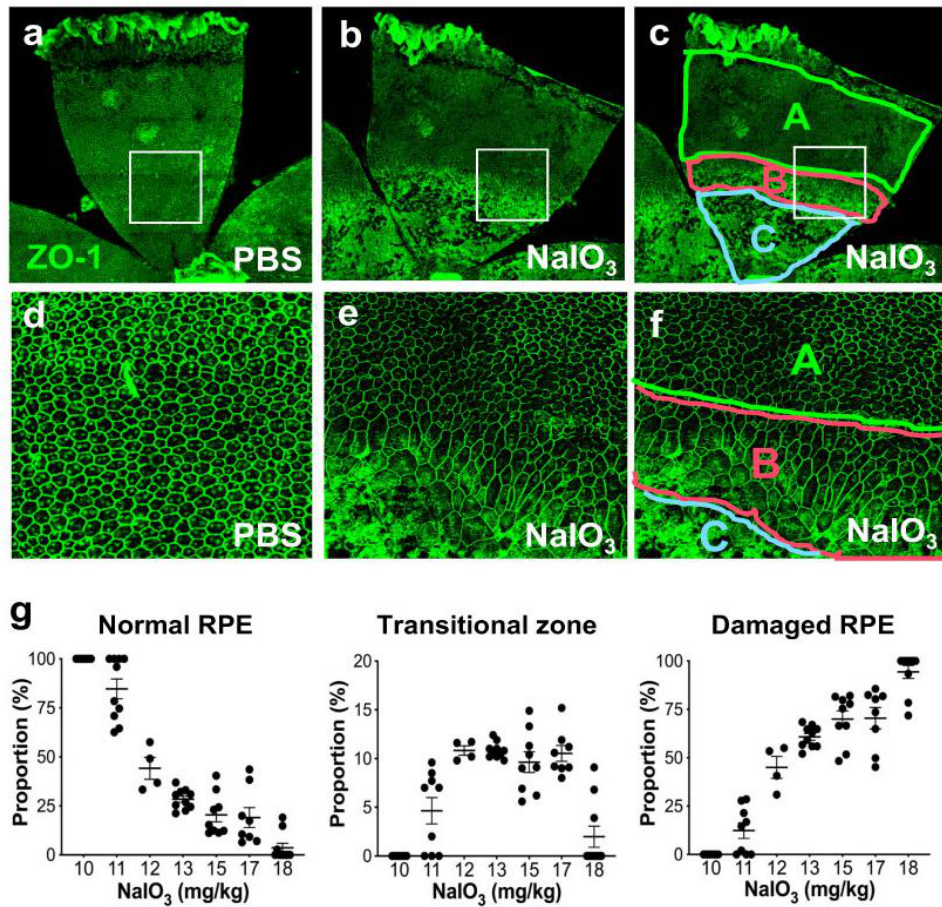
Figure 1. NaIO3-induced oxidative stress causes RPE damage with a narrow range of dose–effect correlation in mice. ( a – f ) NaIO3 causes RPE damage with three distinct morphological regions in mice. Male C57BL/6J mice were injected with vehicle (PBS) ( a , d ) or sodium iodate (NaIO3) at 15 mg/kg body weight (BW) ( b , c , e , f ), and mouse eyes were analyzed 7 days later by RPE flat-mounts with ZO-1 immunofluorescence (green). One petal representing a quarter of the whole RPE flat-mounts is shown in the top panels ( a – c ), with higher magnification images of the squared region in the bottom panels ( d – f ). The RPE damage caused by NaIO3 was divided into three regions: normal cobblestone-like RPE (A, periphery), elongated and enlarged RPE (B, transitional zone), and severely damaged or lost RPE (C, center) ( c , f ). To quantify RPE damage, each region was measured with the number of pixels using ImageJ, and the proportion (%) of each area to the entire RPE was calculated. ( g ) The NaIO3 dose range that causes RPE damage in mice. Male C57BL/6J mice were injected with NaIO3 at 10–18 mg/kg BW and analyzed 7 days later as described above. NaIO3 has a narrow range of dose–effect correlation in causing RPE damage in mice, with no damage at 10 mg/kg BW and nearly complete damage at 18 mg/kg BW. The values represent the means (horizontal lines) and SEM (error bars).